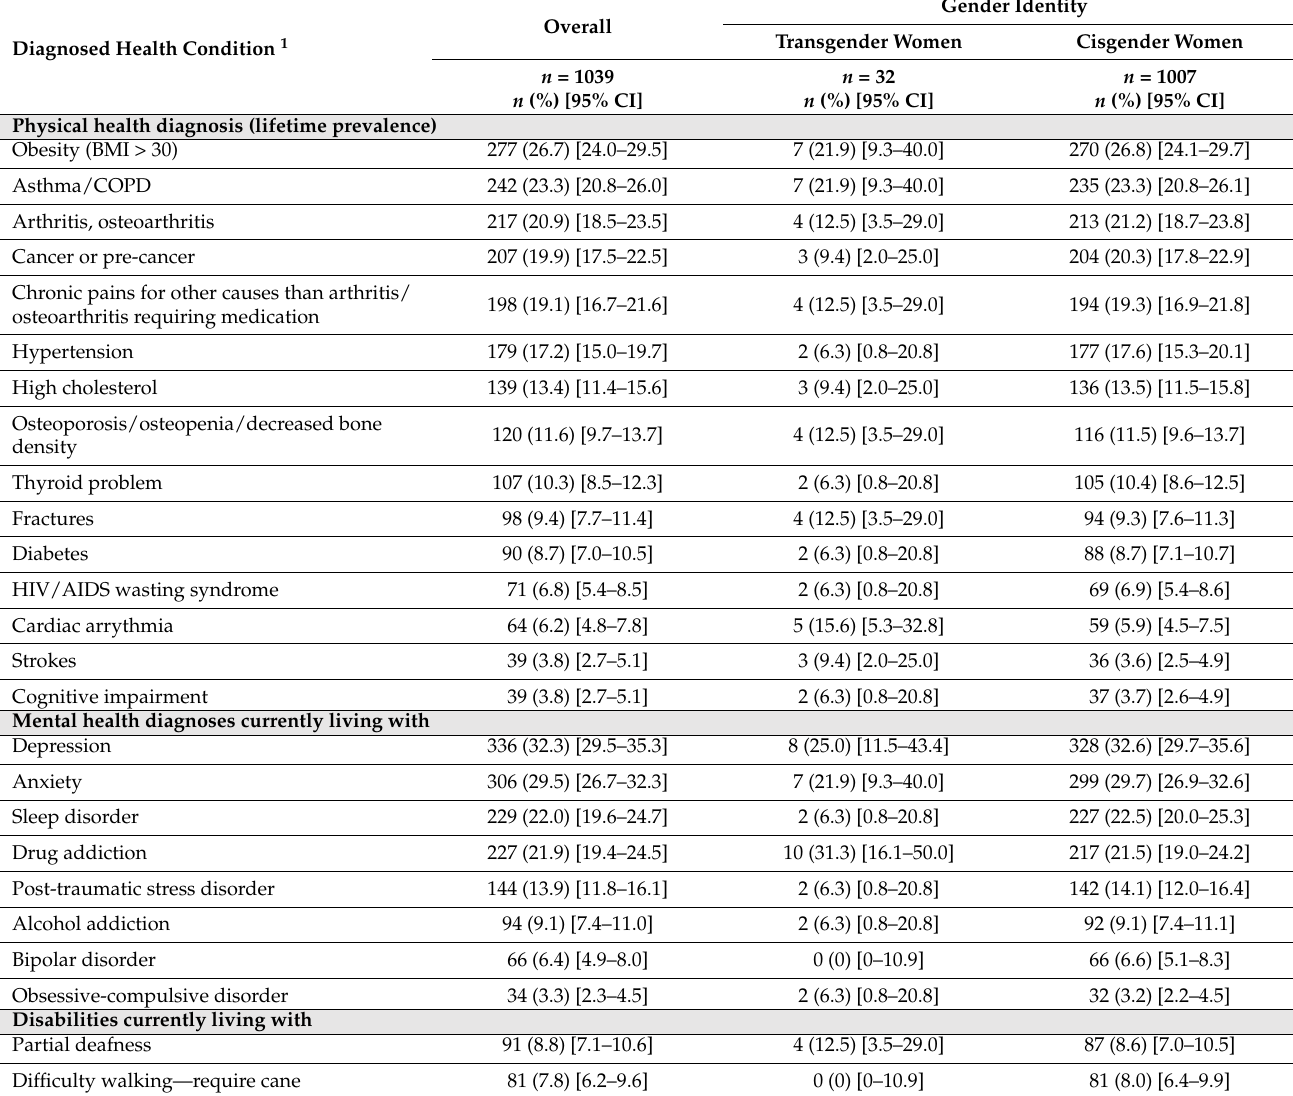
Table 2. Prevalence of comorbidities in participants from the Canadian HIV Women’s Sexual and Reproductive Health Cohort Study (CHIWOS) in decreasing order, and stratified by gender